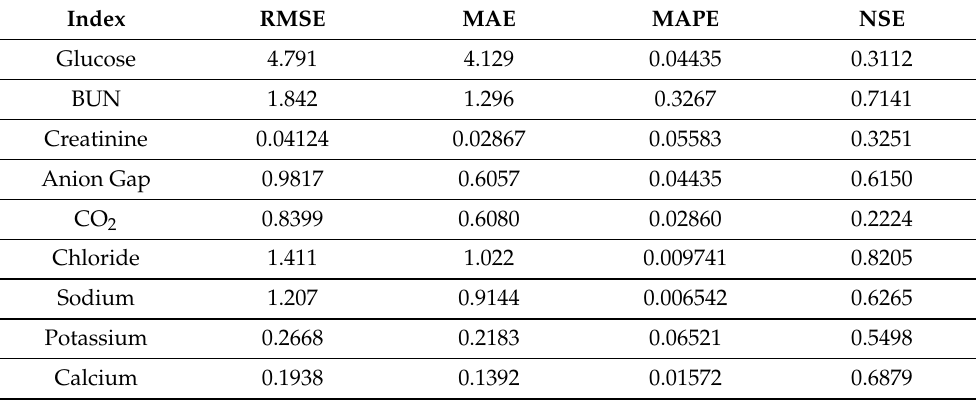
Table A5. Errors in other metrics of the one-step prediction of patient